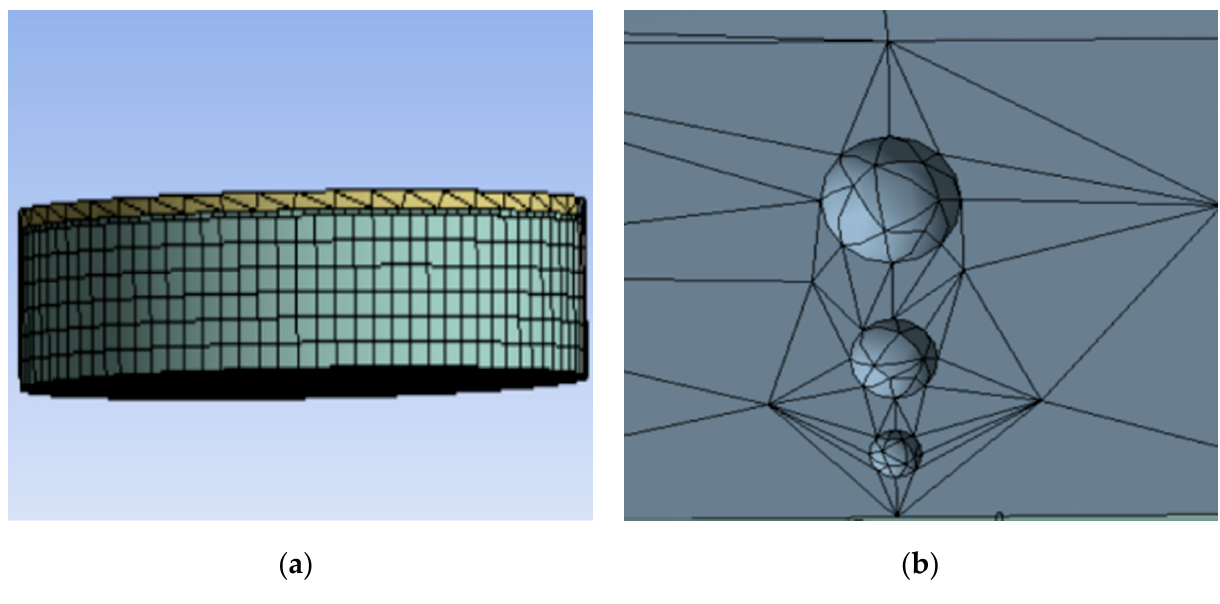
Figure 5. Gridding of models: ( a ) whole; ( b ) pores.